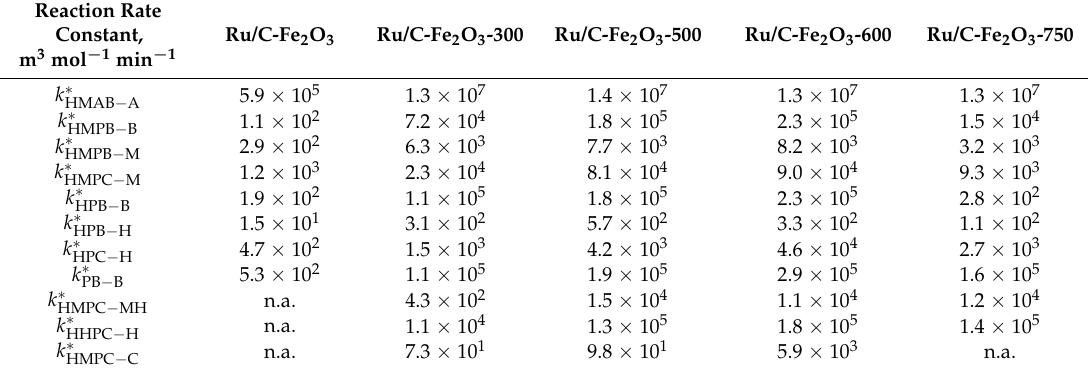
Table 2. Heterogeneous reaction rate constants at 275 ◦